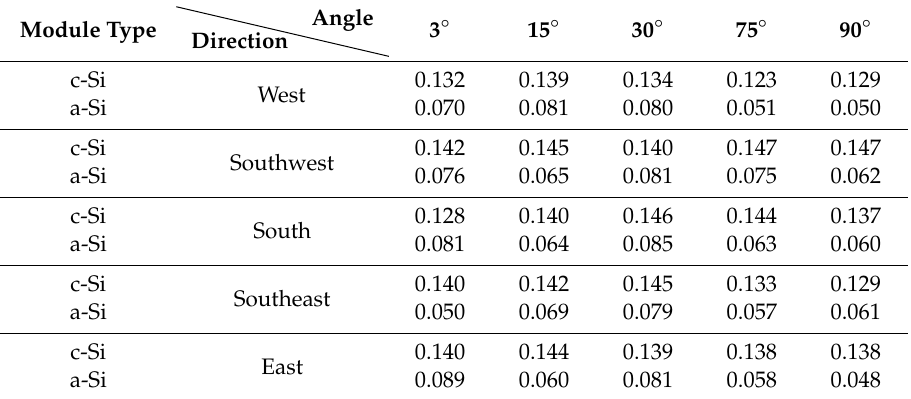
Table 6. Influence coe ffi cient values for di ff erent design elements (BIPV module type, installation direction, and angle).